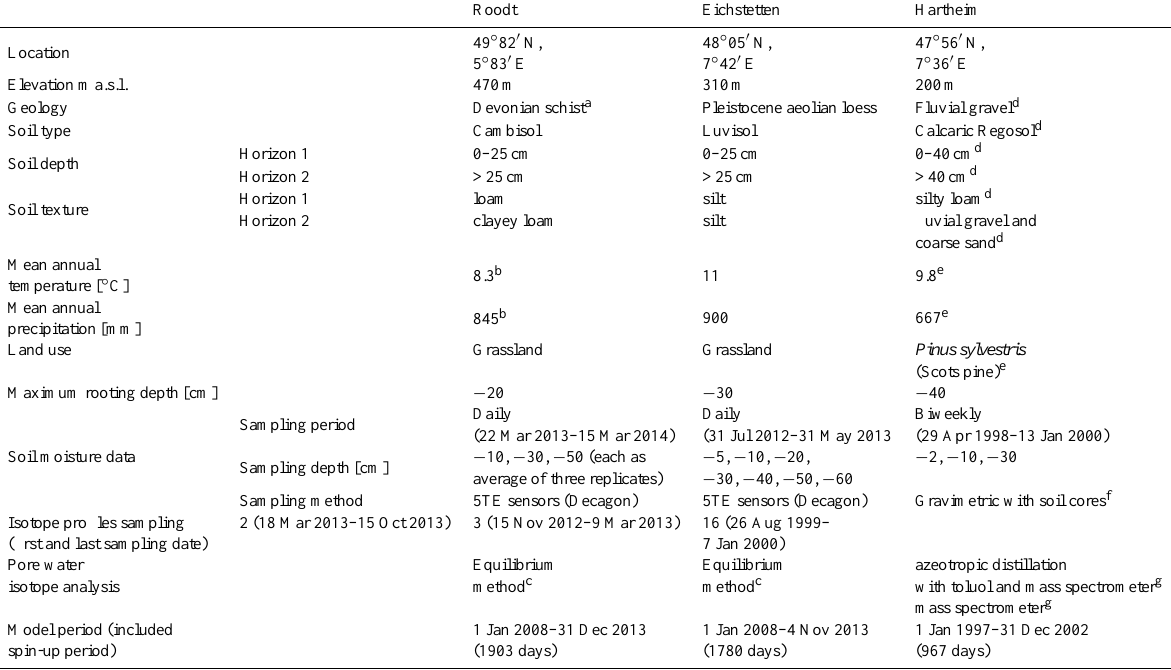
Table 1. Environmental characteristics of the three study sites and the available data for the fitting targets for the inverse